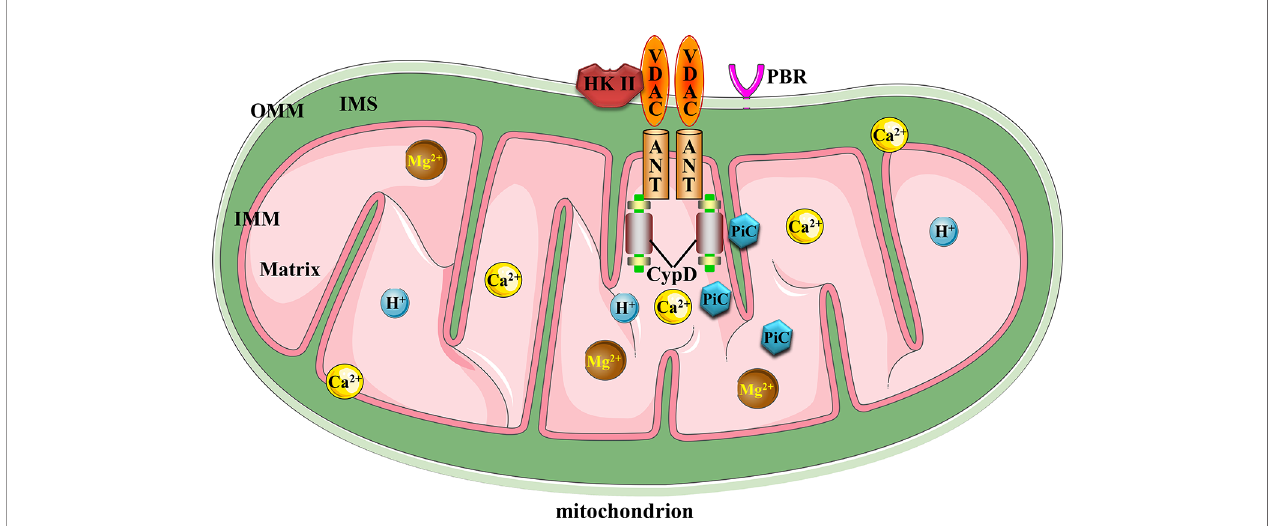
FIGURE 1 | Canonical mitochondrial MPTP molecular structure. Conventional MPTP complex is composed of VDAC, ANT, and CypD. Other factors could also stimulate MPTP